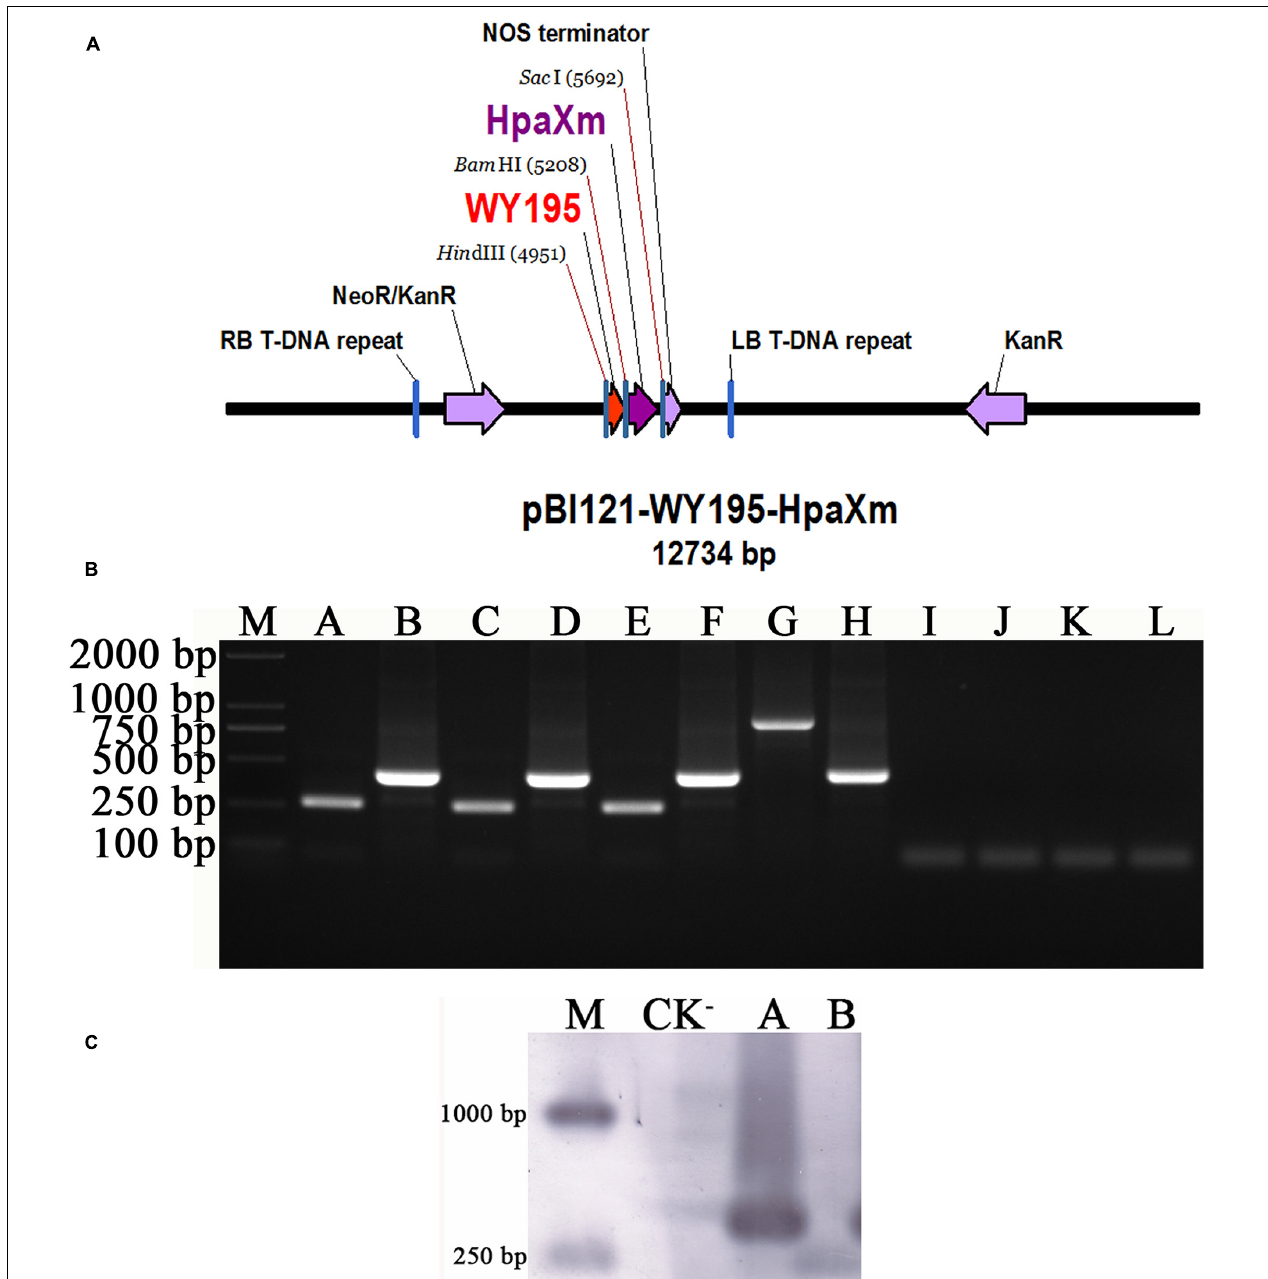
FIGURE 4 | WY195-regulated expression of hpaXm in tobacco. (A) Map of the recombinant vector pBI121-WY195- hpaXm. (B) PCR amplification. (M) Marker 2000; (A) WY195- hpaXm transgenic tobacco plants, primers: WY195F/R; (B) WY195- hpaXm transgenic tobacco plants, primers: hpaXmF/R; (C) CK + , template: O. heveae wild type, primers: WY195F/R; (D) CK + , template: X. citri , primers wild type: hpaXmF/R; (E) CK + , template: recombinant vector pBI121-WY195- hpaXm , primers: WY195F/R; (F) CK + , template: recombinant vector pBI121-WY195- hpaXm , primers: hpaXmF/R; (G) CK + , template: 35S- hpaXm transgenic tobacco plants, primers: 35SF/R; (H) CK + , template: 35S- hpaXm transgenic tobacco plants, primers: hpaXmF/R; (I) CK − , template: N. tabacum wild type, primers: WY195F/R; (J) CK − , template: N. tabacum wild type, primers: hpaXmF/R; (K) CK − , template: ddH 2 O, primers: WY195F/R; (L) CK − , template: ddH 2 O, primers: hpaXmF/R. (C) PCR-Southern blot analysis. (M) DNA molecular weight marker (DIG-labeled); (CK − ) N. tabacum wild type; (A) WY195 promoter; (B) hpaXm .